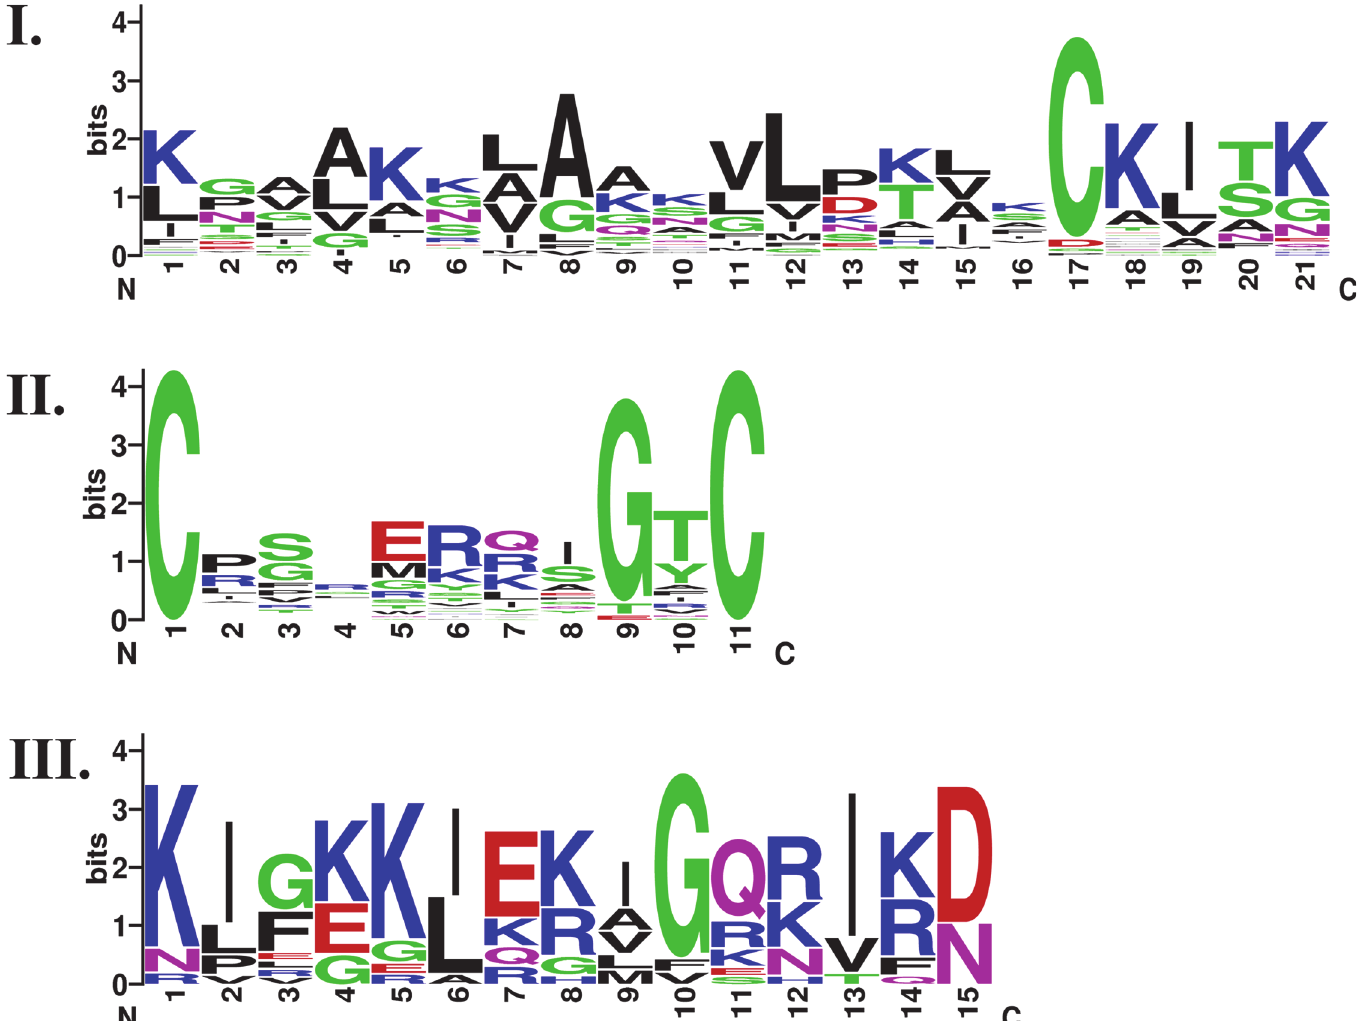
Fig 7. Sequences motifs of the AMP critical regions. Both motif I and III display periodic occurrences of positively charged residues. The helical wheel plots indicate that motif I fits into an amphipathic π -helix (S1 Fig.) and motif III is an amphipathic α -helix (S2 Fig.). Motif II is a cysteine-based